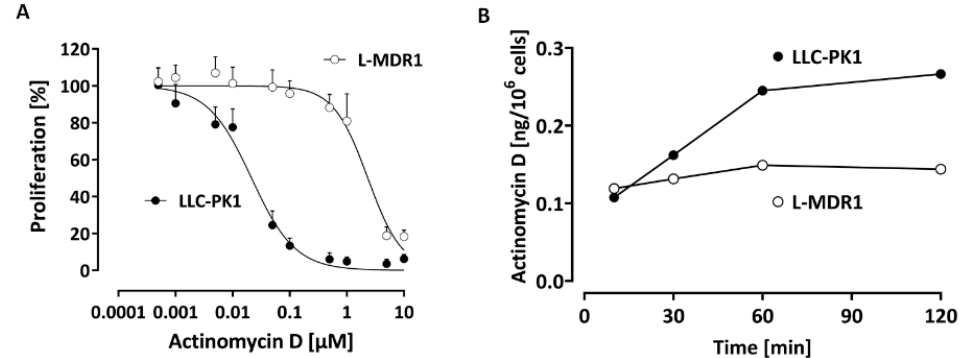
Figure 6. ( A ) Concentration-dependent effect of actinomycin D on the proliferation of the P-gp over-expressing cell line L-MDR1 and the corresponding parental cell line LLC-PK1. Each curve depicts the results of four experiments with each concentration tested in octuplet. Data are expressed as the mean ± SD for n = 32 wells. The IC 50 in L-MDR1 cells was 2.4 ± 0.6 µ M and in LLC-PK1 cells 0.021 ± 0.006 µ M (>100-fold difference). ( B ) Time-dependent uptake of 0.01 µ M actinomycin D in the P-gp over-expressing cell line L-MDR1 in comparison to the parental cell line LLC-PK1. Each data point depicts the mean of a duplicate determination.